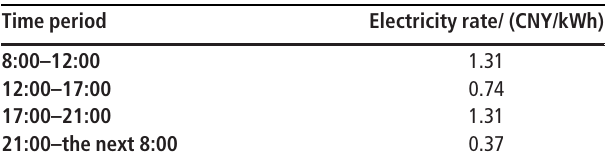
Table 4 Time of day electricity rates Time period